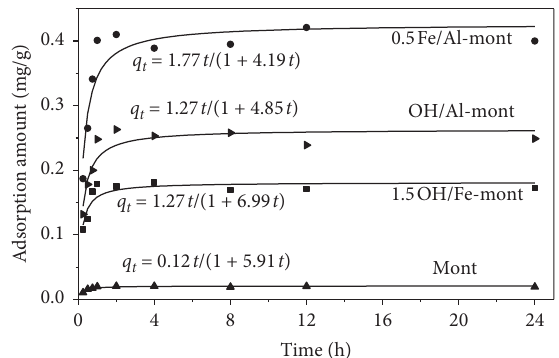
Figure 14: ZEA adsorption kinetics of Mont and pillared Mont. Table 3: Parameters of pseudo-second-order equation for ad- sorption of ZEA. Adsorbing